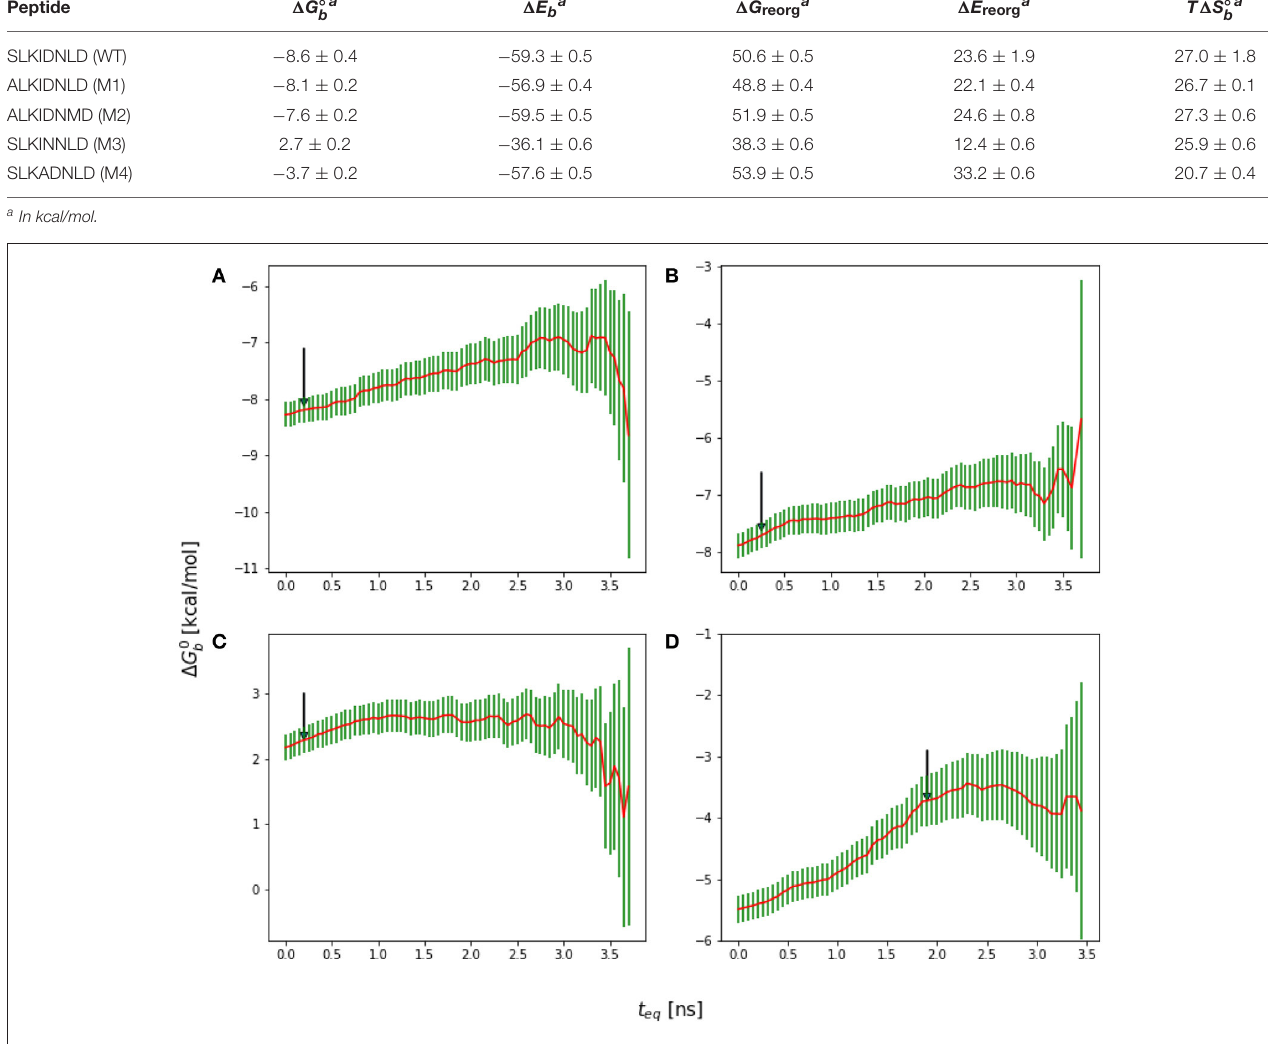
Frontiers in Molecular Biosciences |